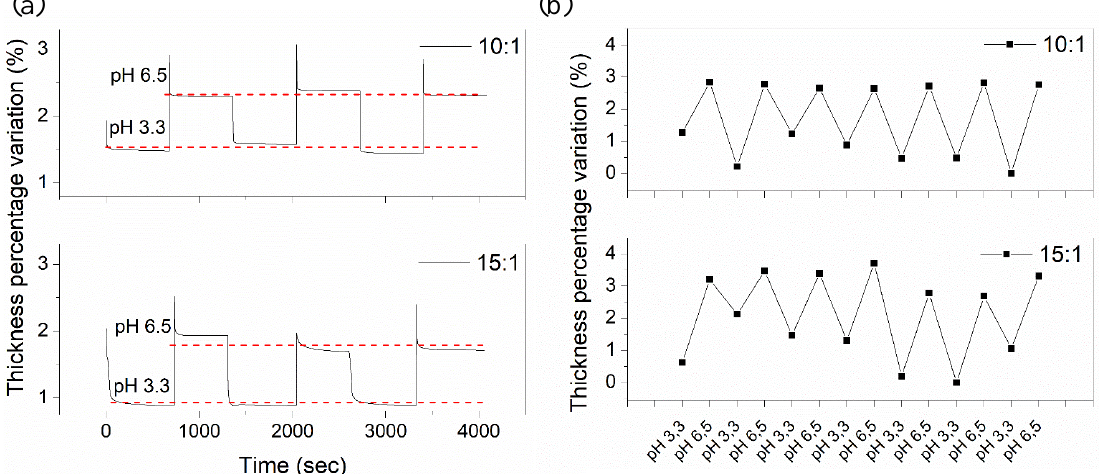
Figure 7. Time dependence of the changes concerning ( a ) QCM thickness and ( b ) ellipsometric measurement upon cycling exposure; Table 3. 3 and 6.5 for two hydrogels (10:1 and 15:1).